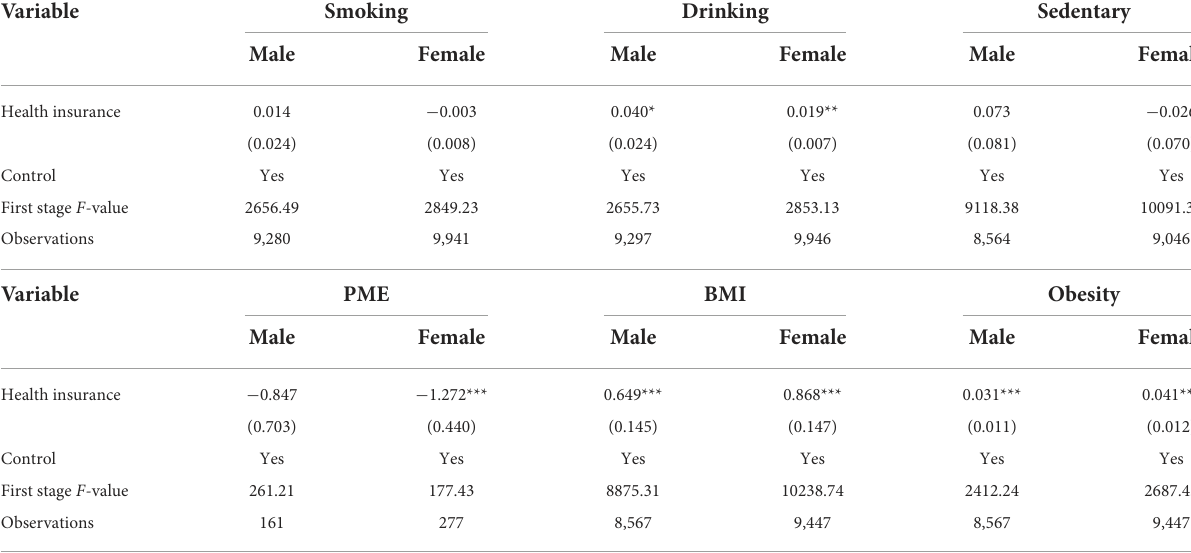
TABLE 5 Heterogeneity by